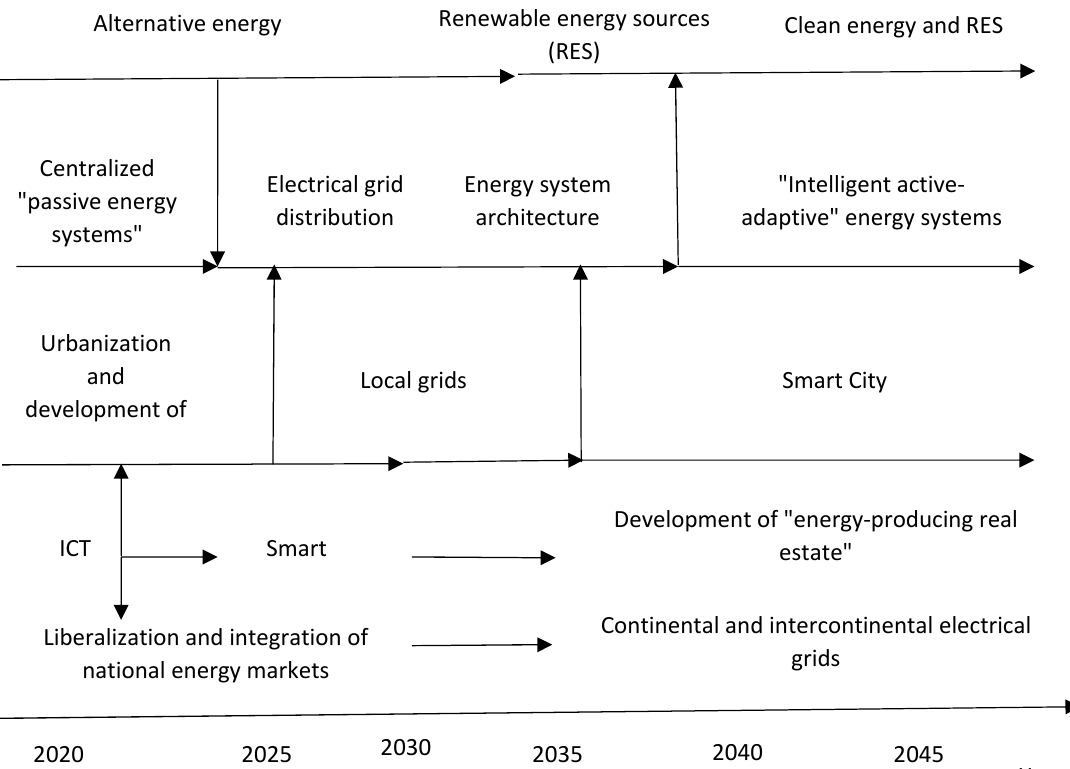
Fig. 4 : Development in the field of energy sector and energy efficiency based on digital technologies (author's forecast based on Foresight methodology)